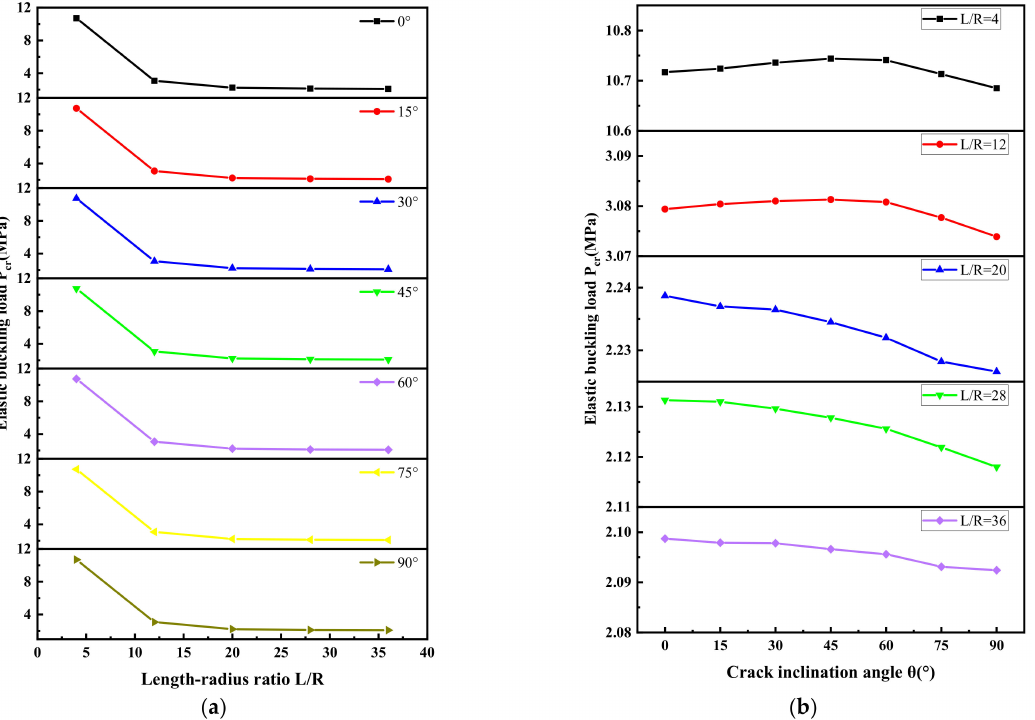
Figure 6. Relation between length-radius ratio and elastic buckling load ( a ) Different length-radius ratios; ( b ) Different crack inclination